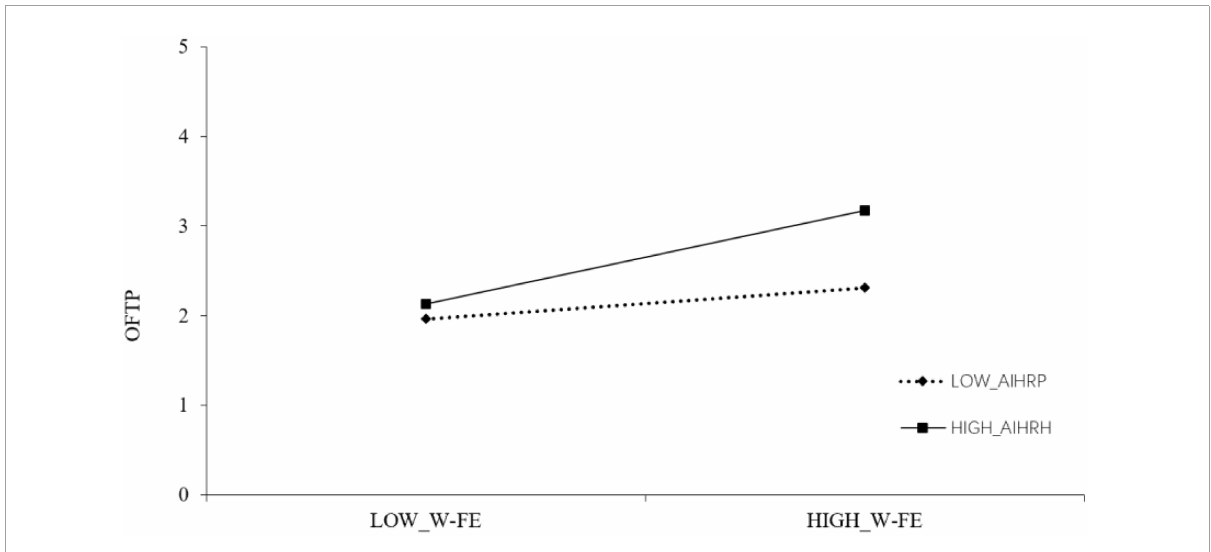
FIGURE2 The moderating role of AIHRP between WF-E and OFTP. W-FE, work → family enrichment; OFTP, occupational future time perspective; AIHRP, age-inclusive HR